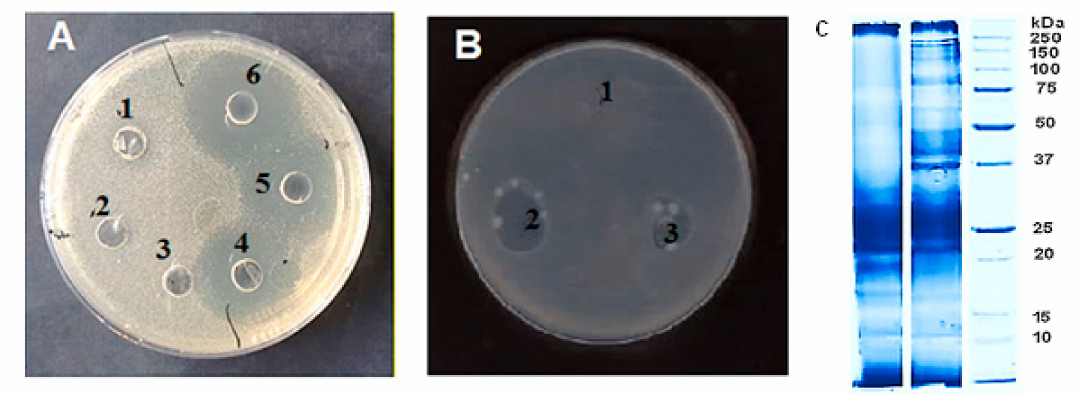
Figure 4. ( A ) Illustrations of sterile areas in investigation of antibacterial activity against the model bacteria of Sample 7 (compounds with Mw > 20 kDa), against C. perfingens at deep anaerobic cultivation; positions 1, 2, and 3: control; positions 4, 5, and 6: Sample 7. ( B ) Antibacterial activity of Sample 5 (fraction with Mw 10–30 kDa) against E. coli NBIMCC 8785 at surface cultivation: position 1: Control, position 2 and 3: Sample 5. ( C ) 12.5% SDS–PAGE with Coomassie Brilliant Blue G-250 staining of protein fractions: position 1 (Samples 5 with Mw 10–30 kDa), position 2 (Samples 7 with Mw > 20 kDa), and position 3 (standard protein marker, Protein Prestained Standards,